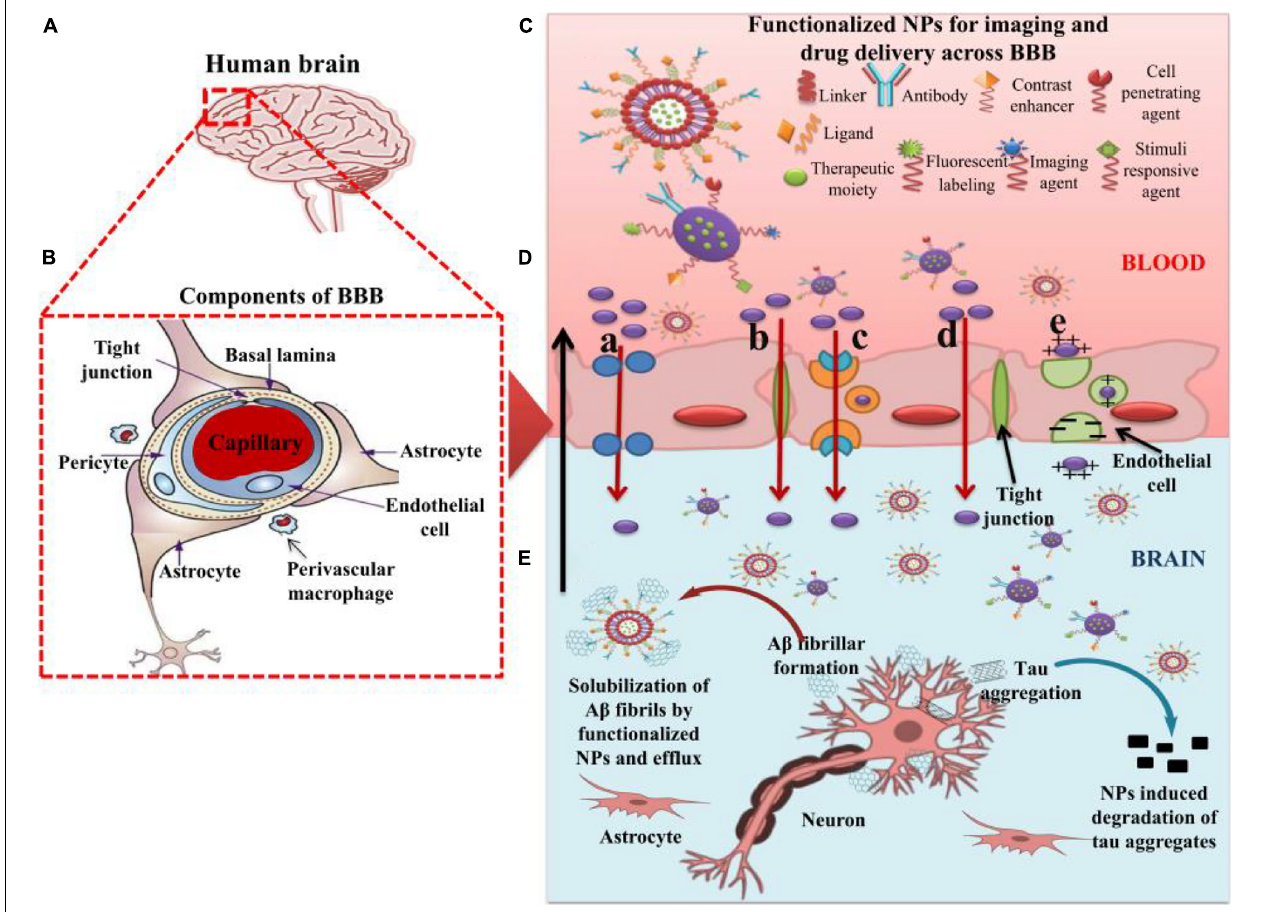
FIGURE 4 | The role of nanoparticles in overcoming the BBB for efficient delivery of therapeutic moieties to treat AD. (A) Image of human brain. (B) Components of the BBB. (C) Functionalized nanoparticles (NPs) for imaging and targeted drug delivery to the AD brain. (D) Different pathways of transport (a–e) across BBB utilized by functionalized NPs. (a) Transport of NPs through cellular transport proteins; (b) transport of NPs through tight junctions; (c) transport of NPs via receptor-mediated transcytosis; (d) transport of NPs via transcellular pathway following diffusion, specifically adopted by gold NPs; (e) transport of cationic NPs and liposomes via adsorption-mediated transcytosis. (E) Effect of functionalized NPs in treating AD via the degradation of tau aggregates and efflux of A β fibrils after getting solubilized by the NPs. AD: Alzheimer’s disease; NPs: Nanoparticles; BBB: Blood–brain